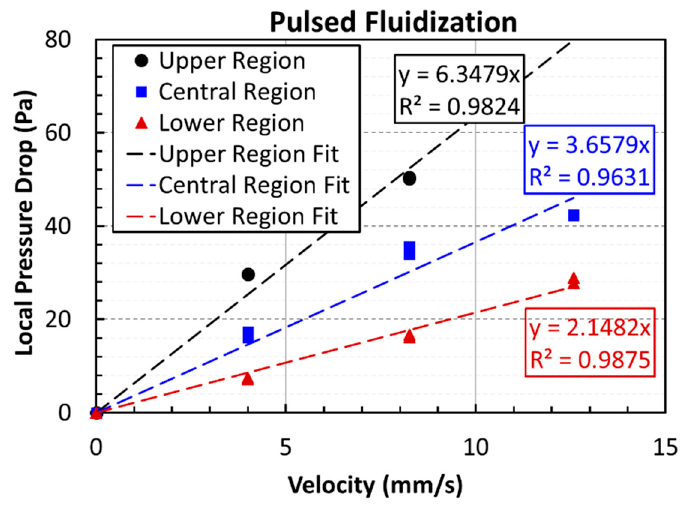
Figure 14. Local pressure drop variations with velocity and corresponding linear-fits for defluidization cycles of pulsed fluidized bed.